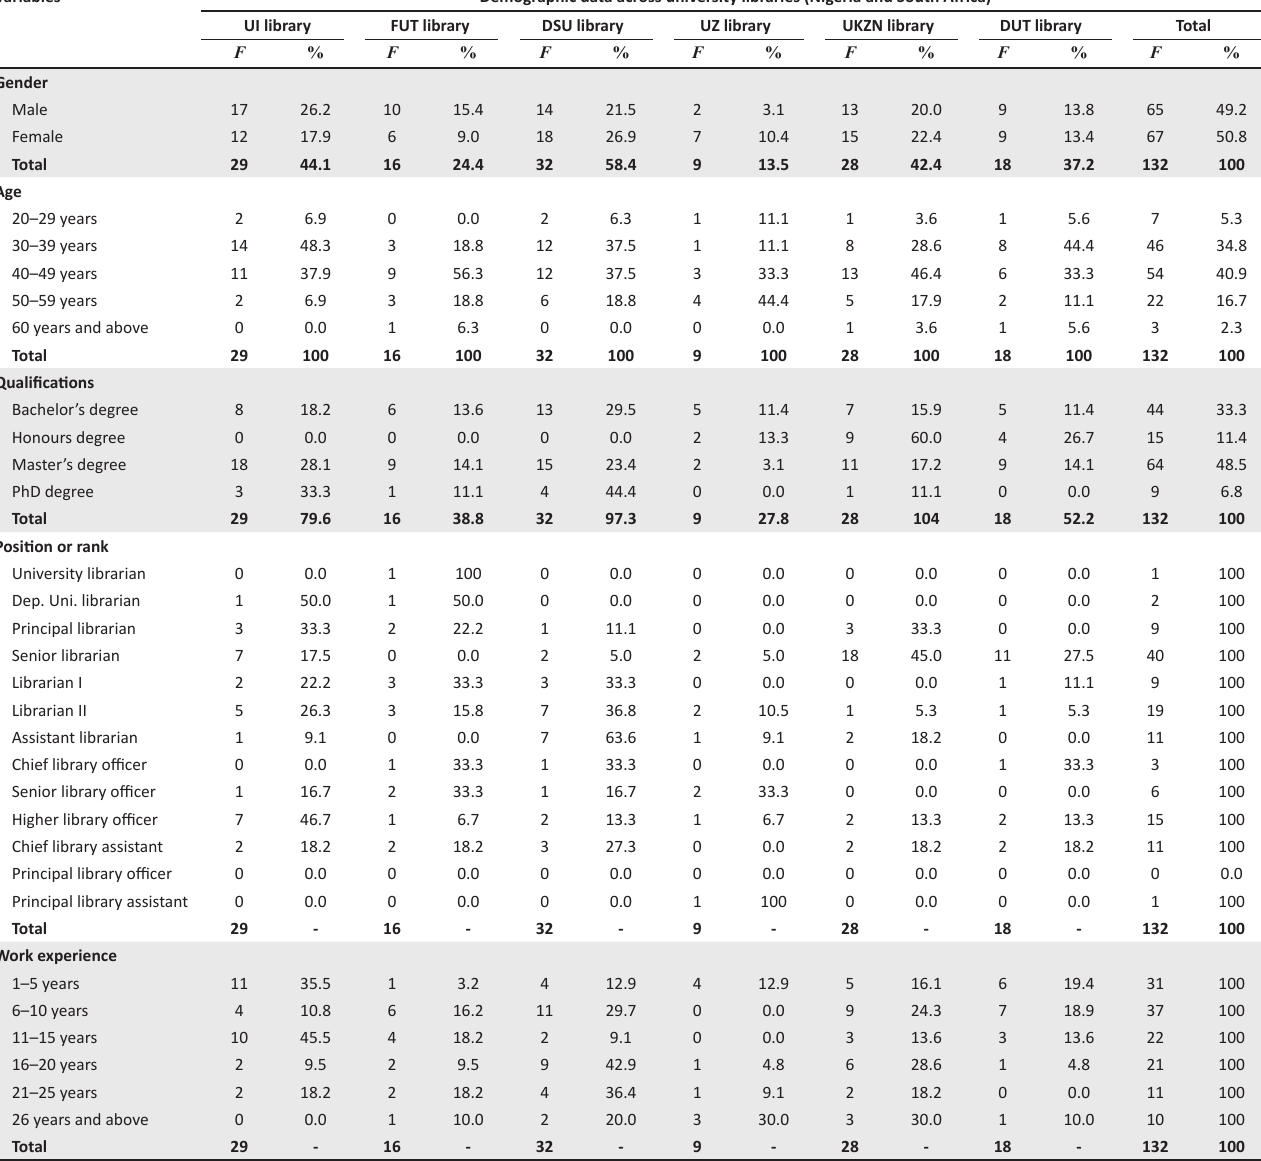
TABLE 1: The profile of the respondents. Variables